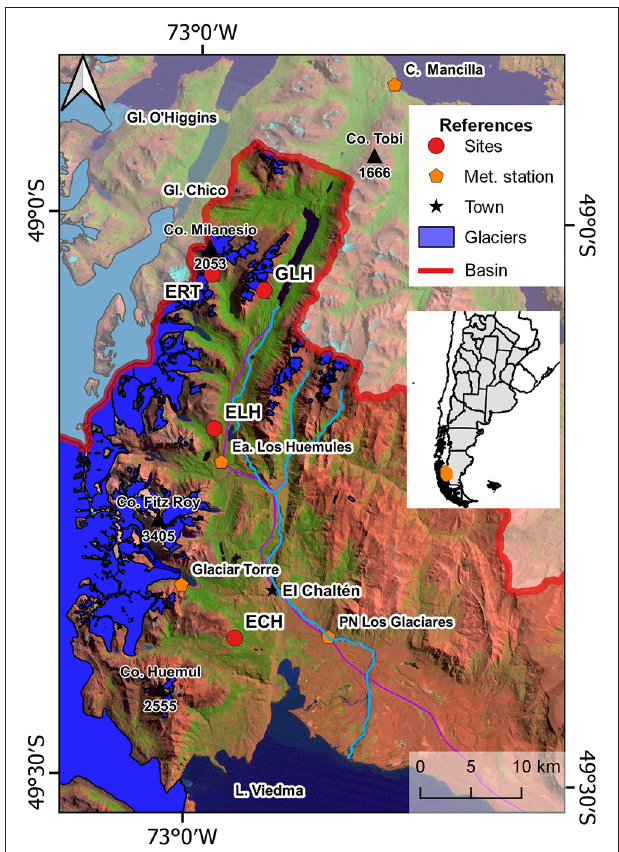
FIGURE 2 | Location of the sample sites along the precipitation gradient. For more details regarding the sampling sites, refer to Table 1 .